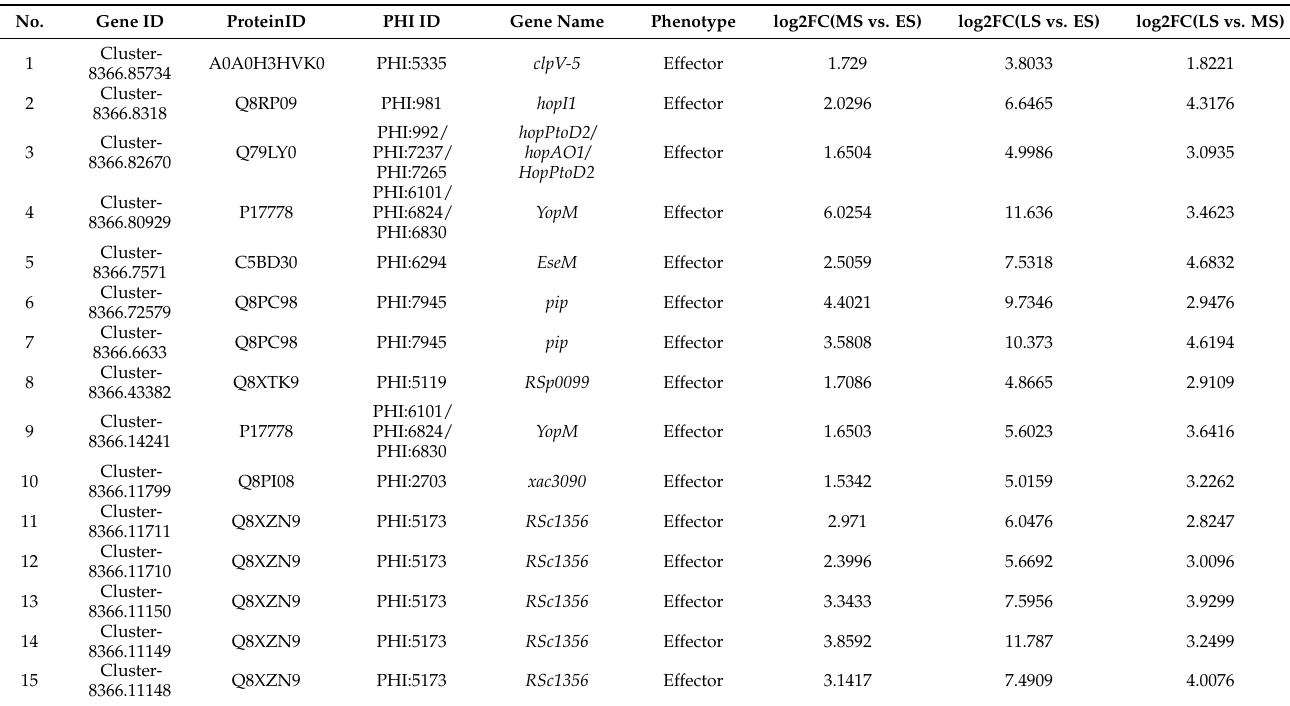
Table 2. Fifteen genes associated with effector in A. protococcarum were significantly upregulated in all the infection stages.